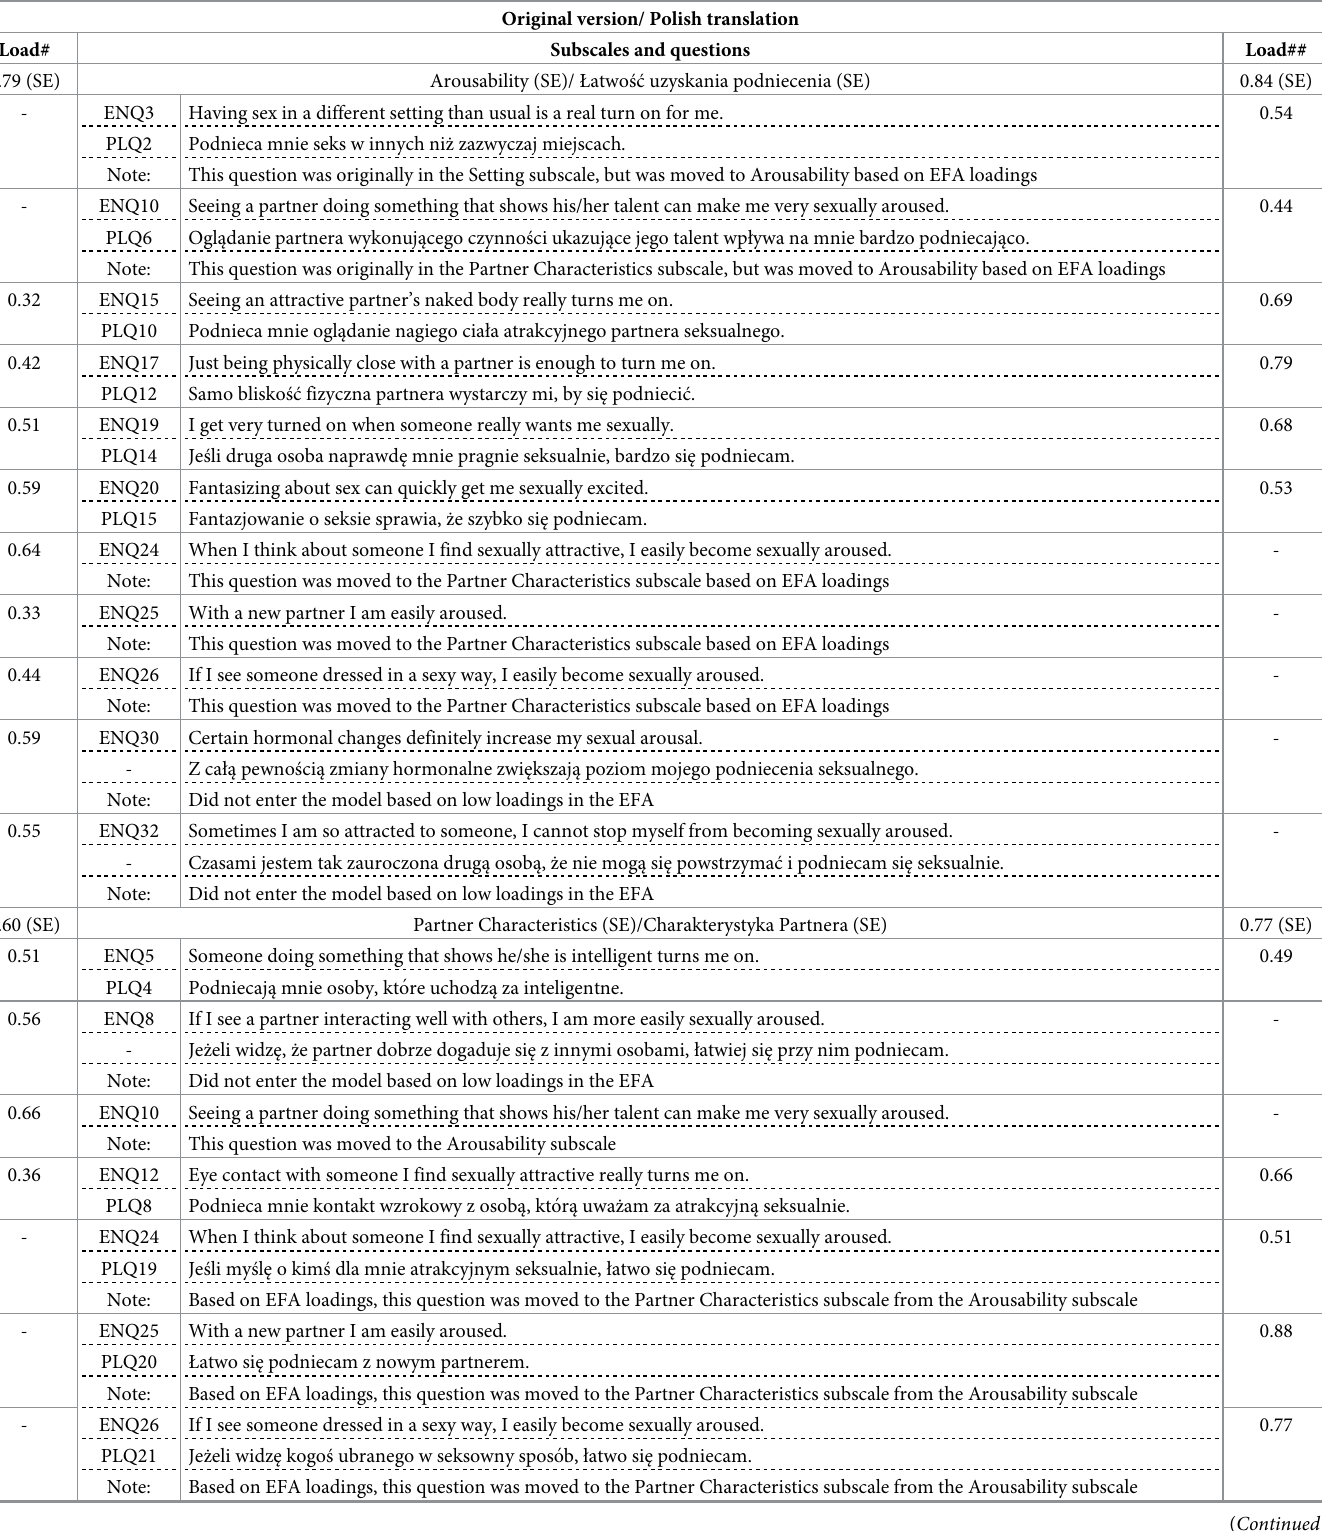
Table 3. Factor loadings and wording of the original version of the SESIIW and the Polish translation in group